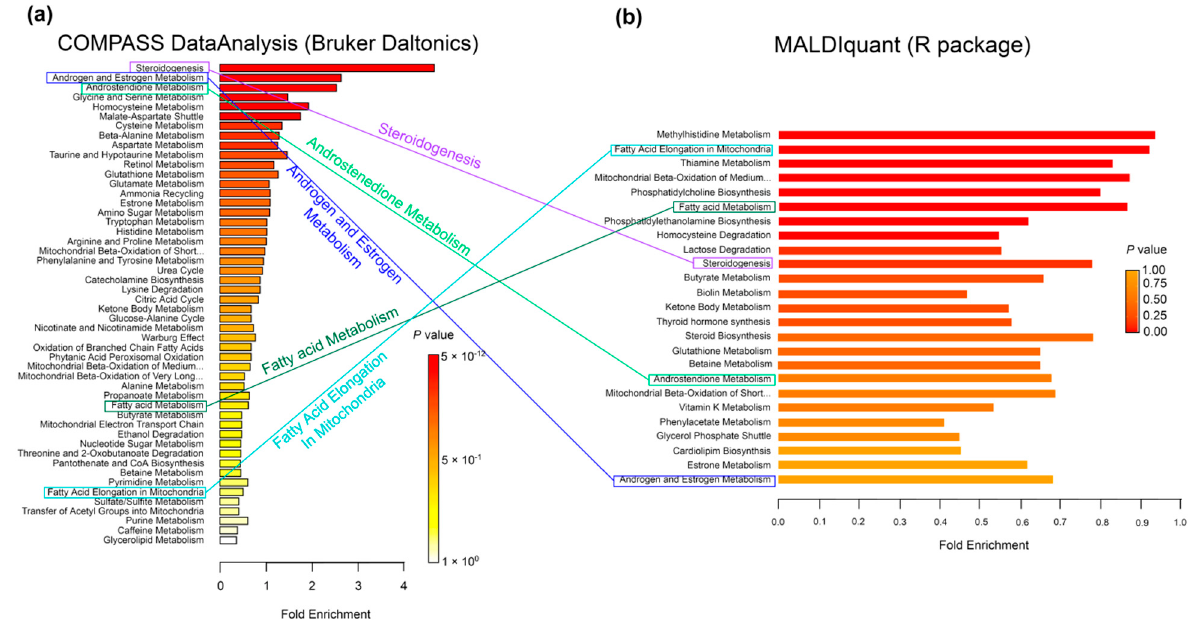
Figure 3. Metabolite set enrichment analysis (MSEA [27]): obesity metabolome, stage three. The results of the analysis of a set of metabolites in samples from patients with stage three obesity using ( a ) MetaboAnalyst web platform 4.0 [5] and ( b ) using MetaboAnalyst 5.0. The color gradient from red to yellow shows the level of significance ( p -value), which characterizes the reliability of the detection of metabolic pathways based on DIMS data.